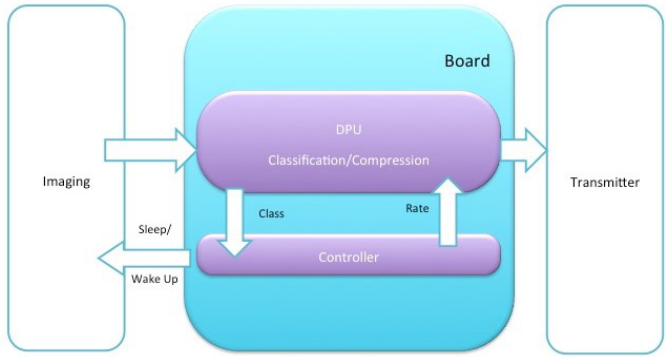
Figure 1. Block diagram of the intelligent thermal image processing unit.